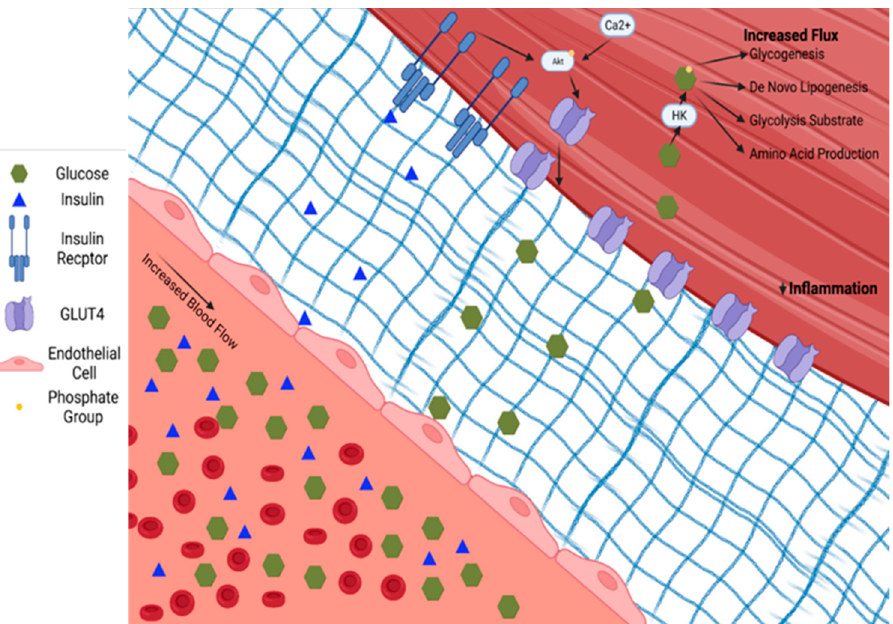
Figure 3. Exercise training restores proper blood flow to skeletal muscle and increases insulin. The extracellular matrix becomes less fibrotic, allowing the passage of glucose and insulin to skeletal muscle. Intramuscular glucose metabolism increased, thereby decreasing the allosteric downregulation of glucose disposal and augmentation of the glucose gradient for facilitated glucose transport. Decreased intracellular DAG and toxic lipid accumulation improves post-receptor insulin action. Hexokinase (HK). Phosphokinase B (Akt).